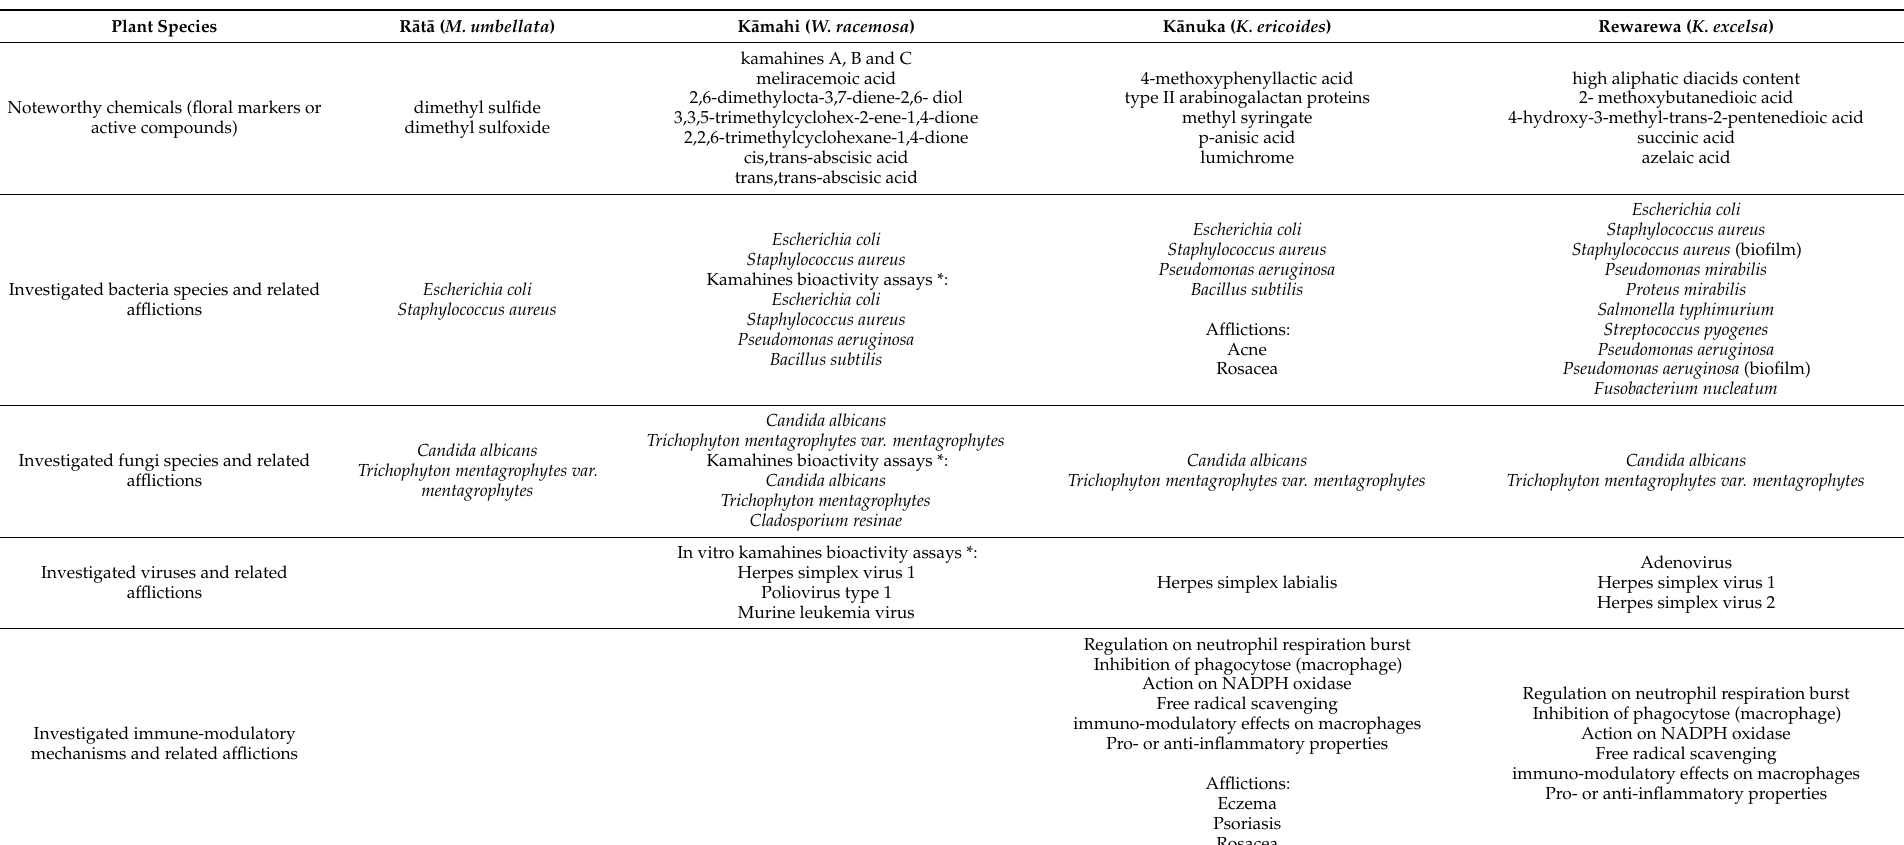
Table 2. Summary of chemicals and biological activities of the four honeys of interest investigated in the literature. This table does not display a proven activity but rather the work that has been carried out so far. For more details, please read the corresponding sections of this